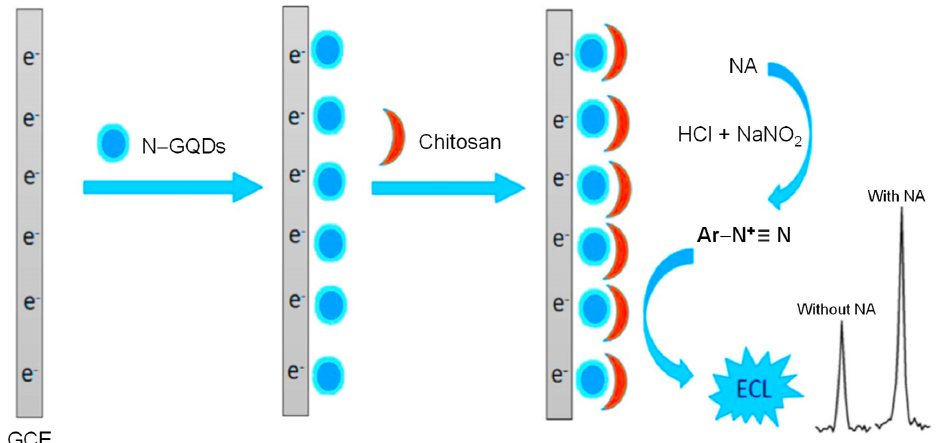
Figure 11. Detection strategy of nitroaniline by N-GQDs and chitosan functionalized glassy carbon electrode (GCE) [207].